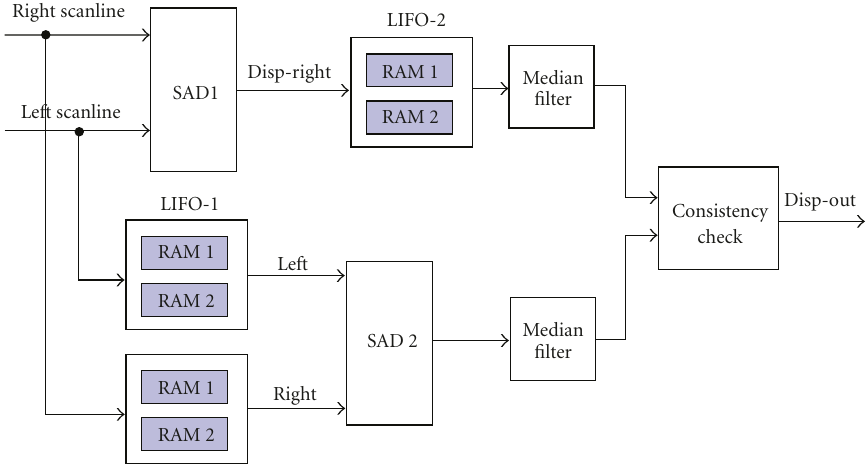
Figure 3: Block diagram of the SAD-based system with left-right consistency check.